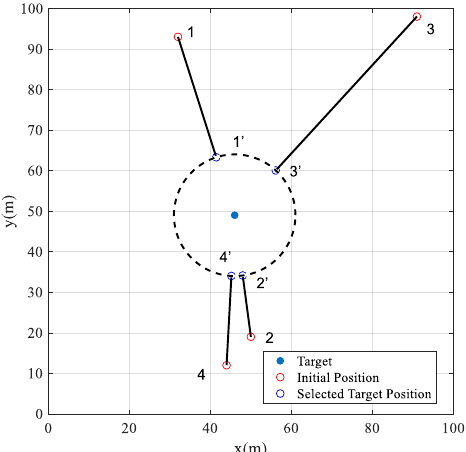
Figure 9. Position adjustment with pursuit conditions.